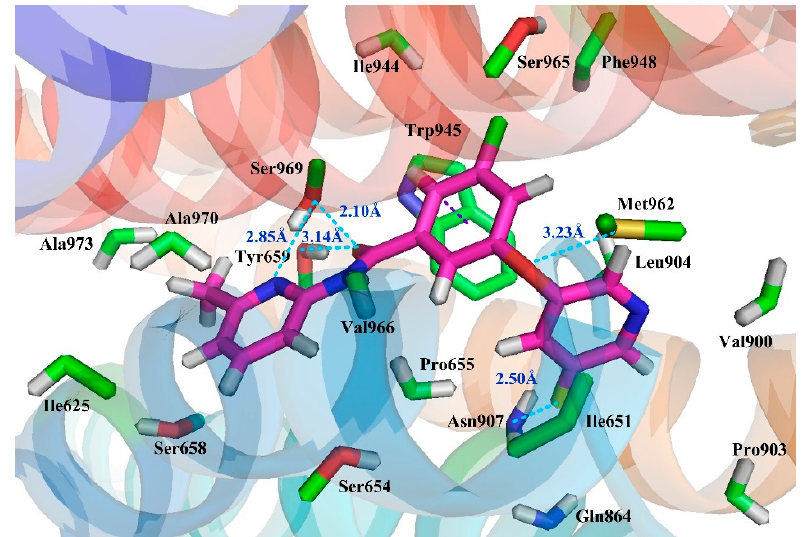
Figure 5. Putative interaction between compound 74 and mGluR5. The amino acid residues are shown by the stick model, in which the molecular carbon and the amino acid residue carbon are represented by pink and green, respectively; the N, O, S, F atoms are represented by navy blue, red, orange, and yellow, respectively; the H-bond force and the π – π stack are represented by blue and purple dotted lines, respectively.